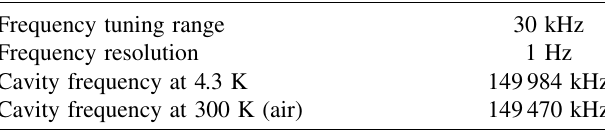
TABLE I. Multistub cavity tuner specifications.